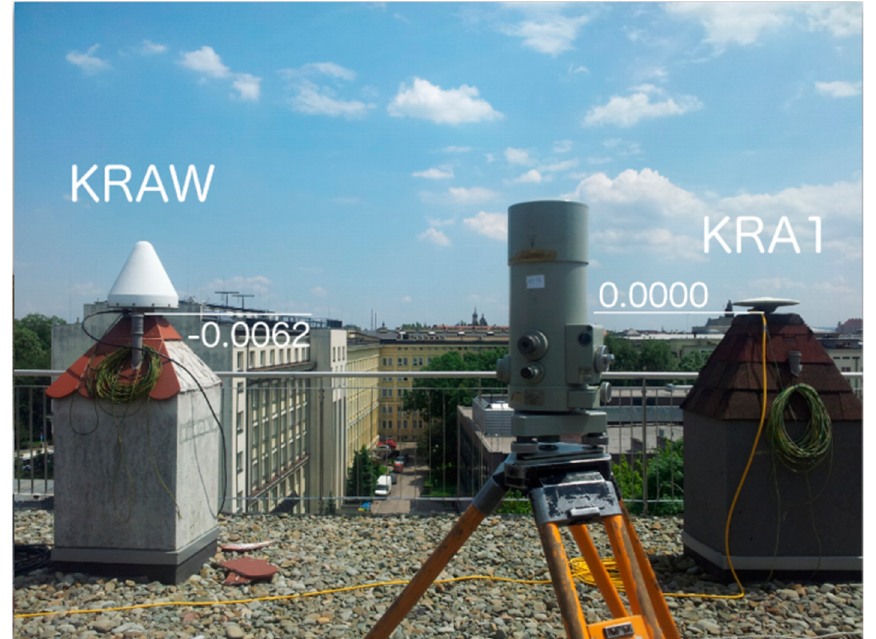
Figure 10. Height difference (m) between the KRAW and KRA1 antenna reference points from precise levelling.